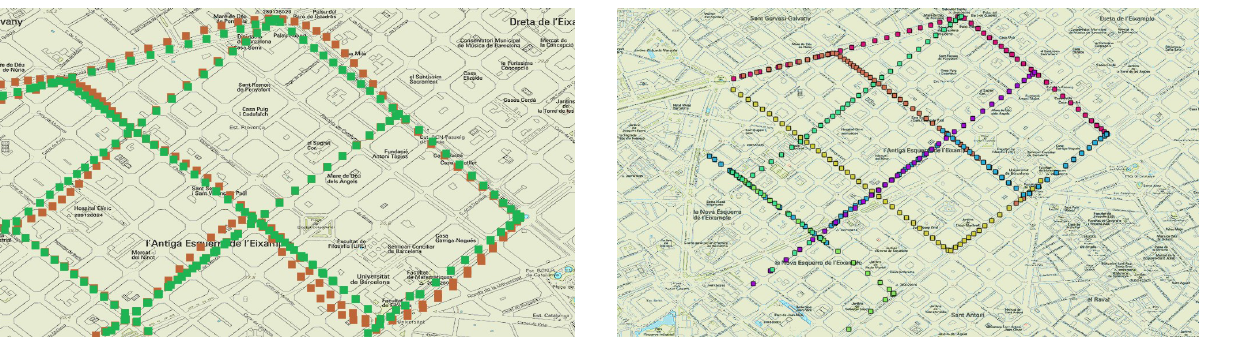
Figure 6. Estimated locations of a C-AQM data set before (red) and after (green) positioning post-processing.